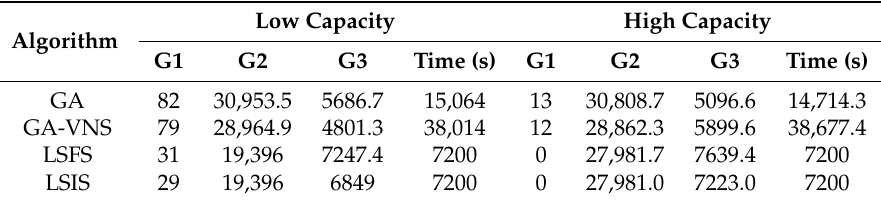
Table 7. Result of Case 7 (low capacity: 4500, high capacity: 9000).